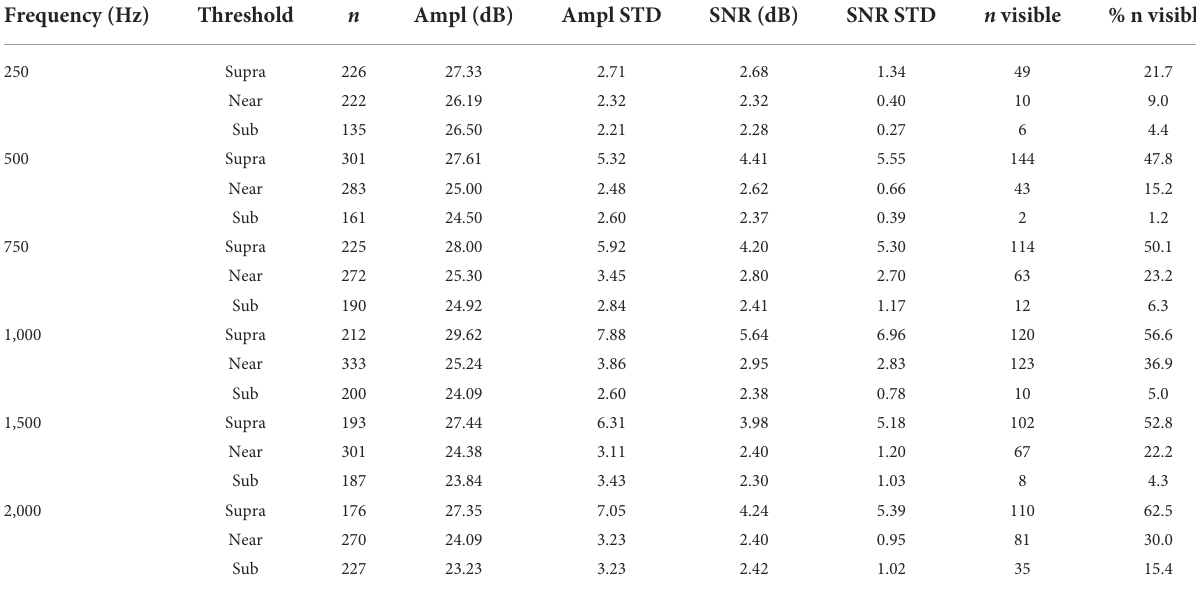
TABLE 4 Overview of the stimulation frequencies, the individual intensities, and the